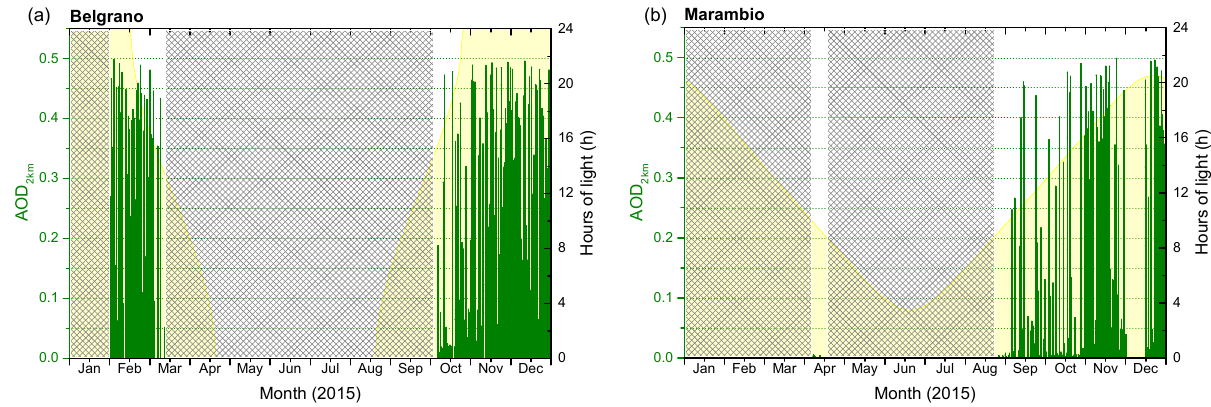
Figure 3. Time series of the aerosol optical depth (AOD) in the first 2km of the troposphere as observed at Belgrano (a) and at Marambio (b) during 2015. The horizontal scale indicates the time of the year while the left vertical scale shows the AOD. The scale on the right shows the hours of light at each station (shown in yellow in the plots). Note that the same scales apply to both figures. Time periods without MAX-DOAS observations (i.e., instrumental issues or SZA>75 ◦ ) are indicated with shaded areas.